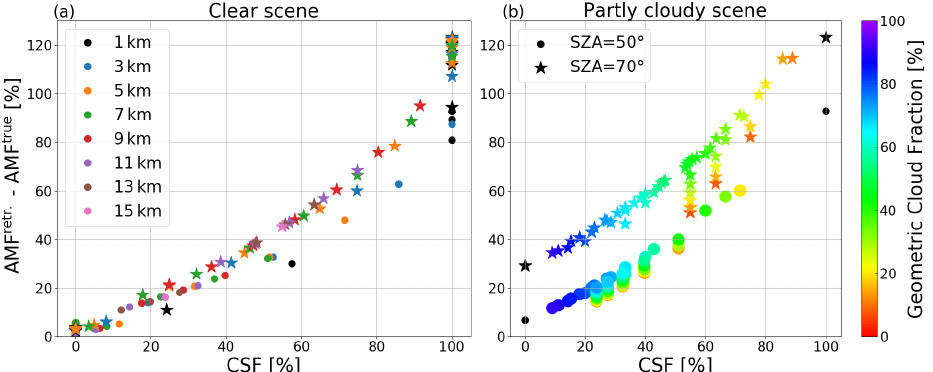
Figure 8. NO 2 AMF retrieval bias for the liquid cloud cases in the cloud shadow with various spatial resolutions over the clear (a) and the partly cloudy (b) region, depending on cloud shadow fraction. Circles and stars are the cases for SZA = 50 and 70 ◦ , respectively. See text for further details.